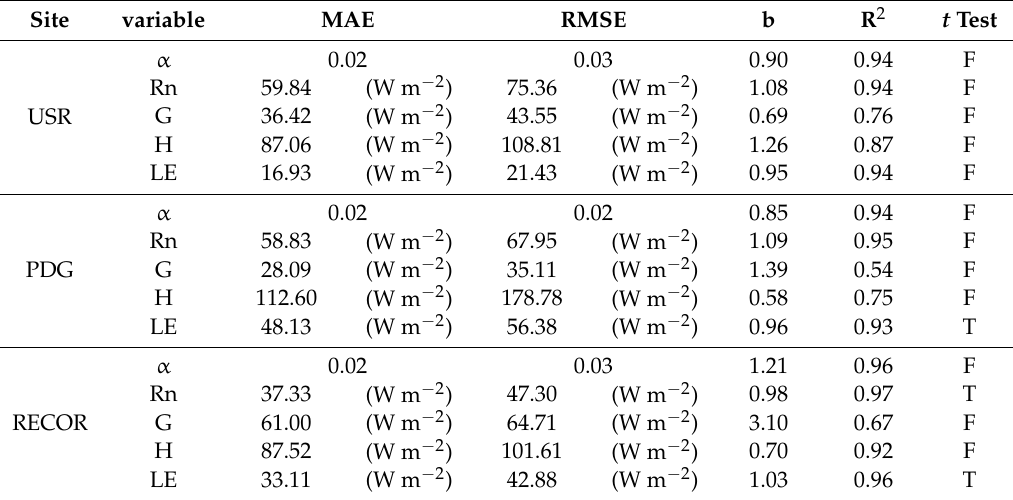
Table 5. Statistical analysis results from instantaneous METRIC estimates for surface albedo ( α ), net radiation (Rn), soil heat flux (G), sensible heat flux (H), and latent heat flux (LE) at USR (sugarcane), PDG (woody savanna), and RECOR ( sensu-stricto savanna) experimental